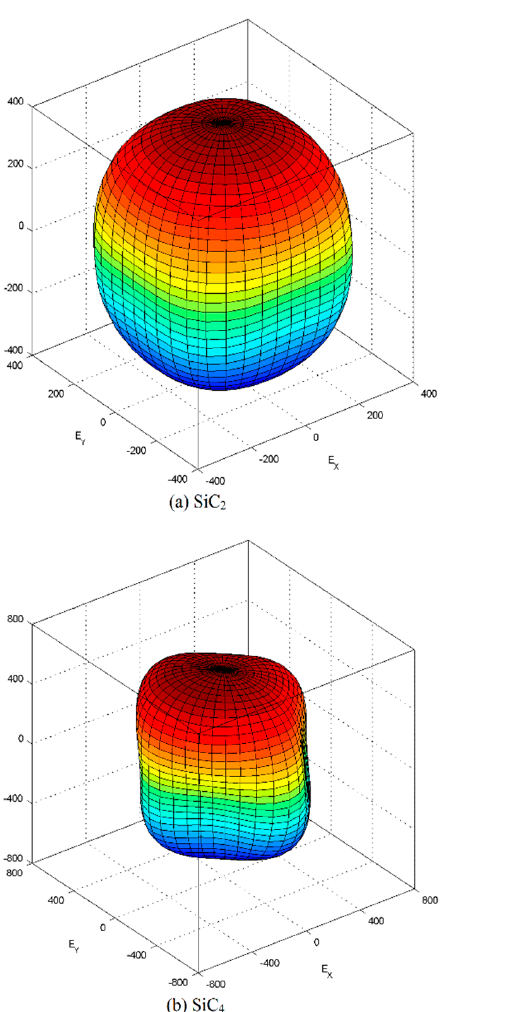
Figure 4. The directional dependence of Young’s modulus for SiC 2 ( a ) and SiC 4 ( c ); 2D representation of Young’s modulus in the xy plane, xz plane, and yz plane for SiC 2 ( b ) and SiC 4 ( d ).